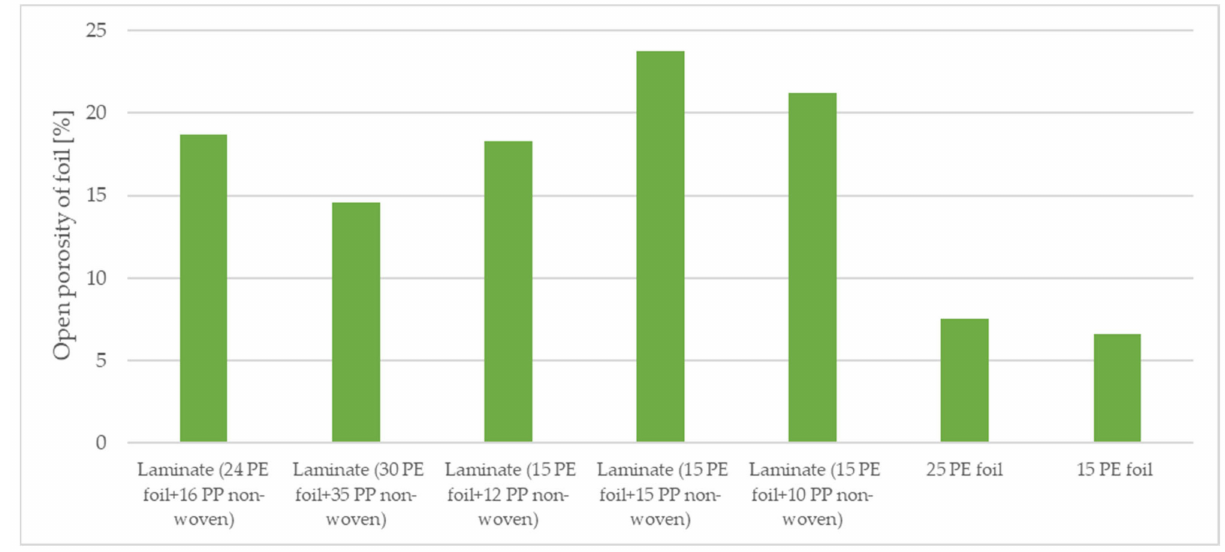
Figure 8. Open porosity of the tested materials.